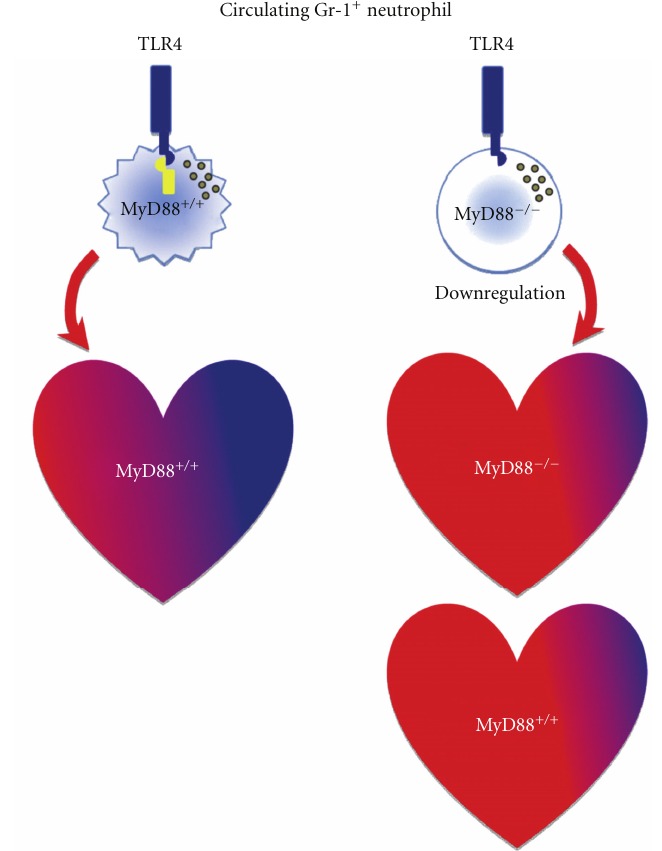
Figure 4: Schematic diagram of cardiac infarct size (blue region) after acute ischemia and reperfusion (I/R) and neutrophil CXCR2 down- regulation by deletion of myeloid di ff erentiation factor 88 (MyD88) globally ( right top ) and targeted to leukocytes only ( right bottom ). (Schmid-Sch¨onbein, [103], used with